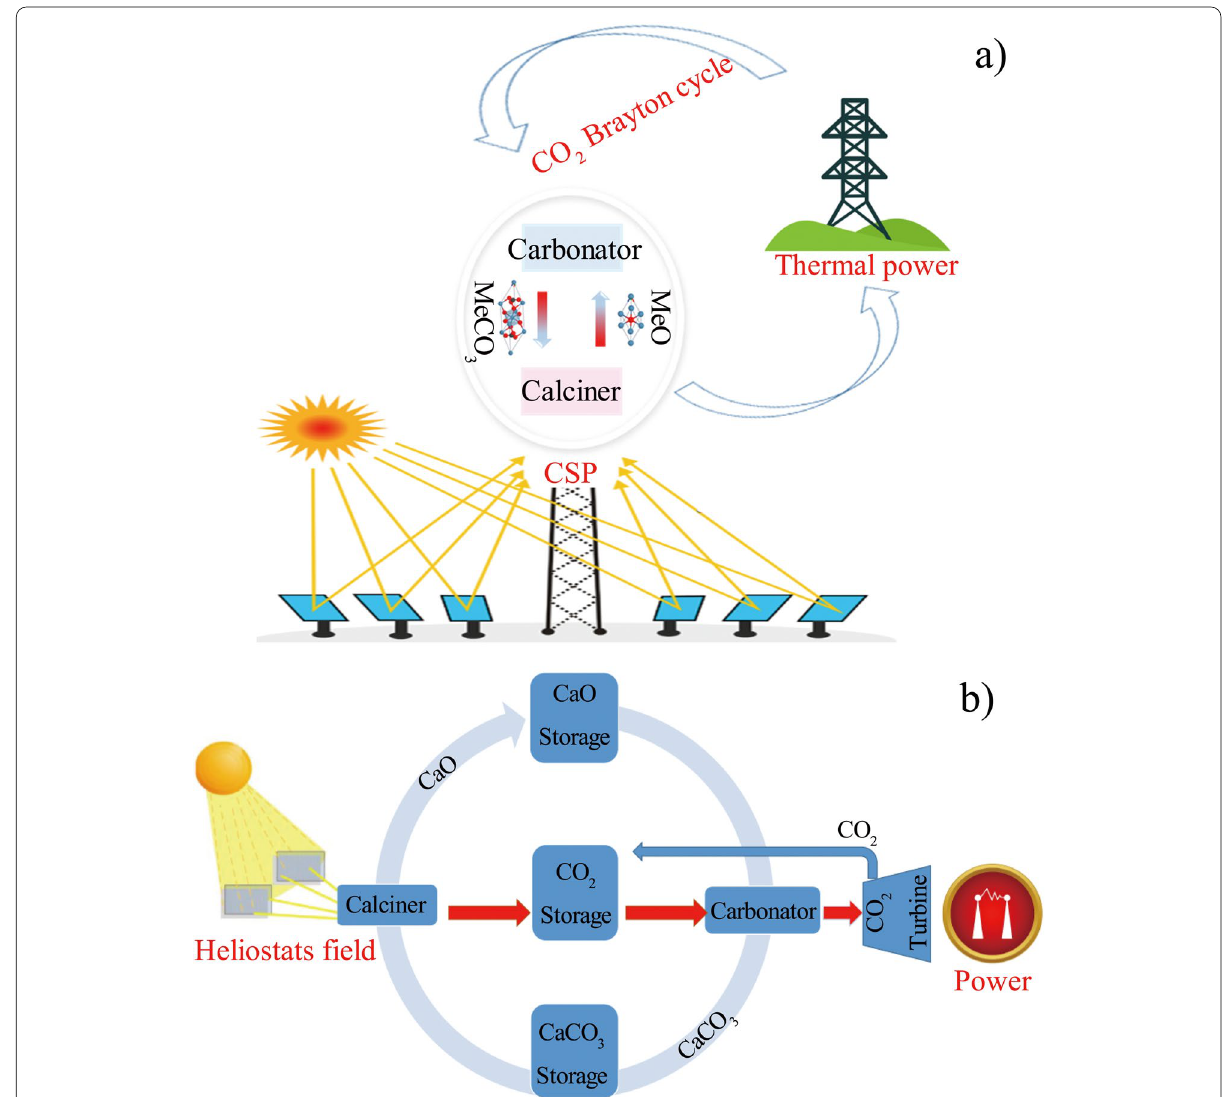
Fig. 10 Schematic representation of the calcium-looping based TCES for CSP ( a ), and the flow chart ( b